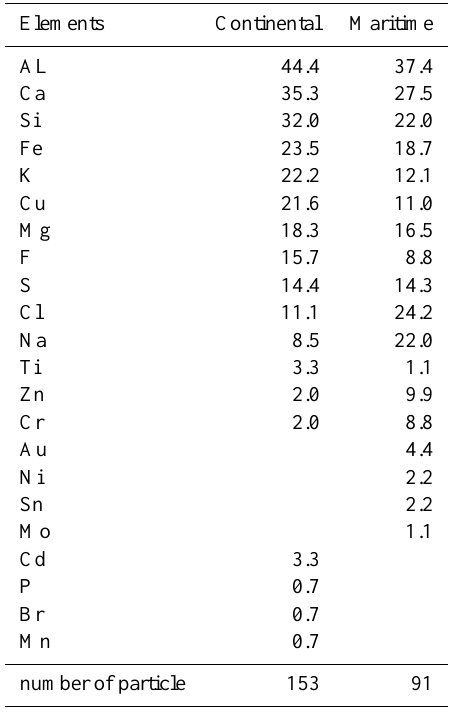
Table 4. Frequency of occurrence (%) of elements in individual particles in maritime and continental air masses.